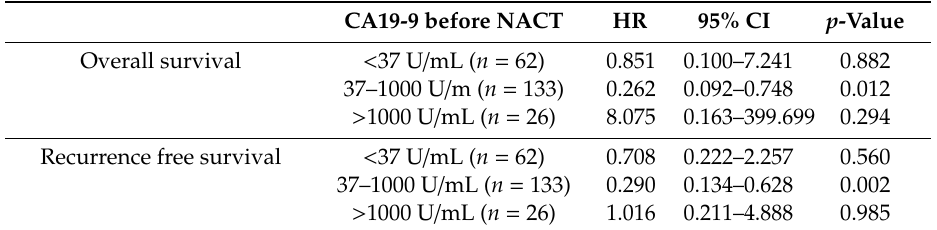
Table 2. Prognostic e ff ects of carbohydrate antigen 19-9 concentration before neoadjuvant chemotherapy on overall survival and recurrence free